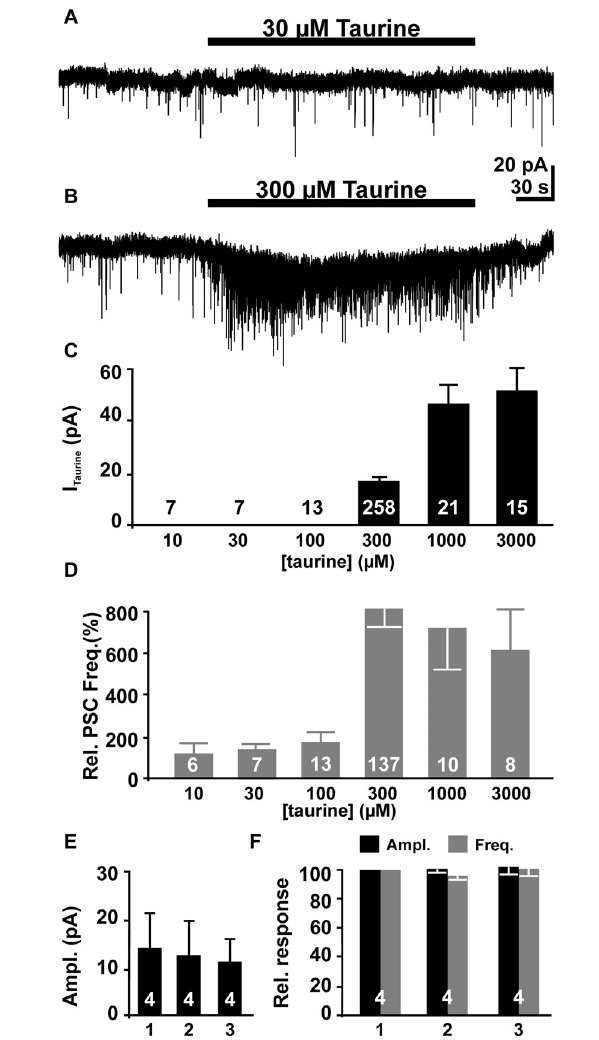
FIGURE 3 | The effect of bath-applied taurine on pyramidal neurons . (A) Whole-cell voltage-clamp recording from a pyramidal neuron. Bath application of 30 µ M taurine did not affect the holding current or the frequency of the PSCs. (B) Bath application of 300 µ M taurine induced an inward current and a massive increase in the frequency of PSCs. (C) Statistical analysis of inward current amplitudes induced by different taurine concentration. (D) Statistical analysis of relative PSC frequency (normalized to control intervals) in the presence of different taurine concentrations. Note that the effect of taurine on PSC frequency displays a clear threshold behavior. (E, F) Neither the amplitude of the inward current (E) , nor amplitude (black bars) and frequency (gray bars) of taurine-induced PSCs differ significantly in three consecutive applications. Bars represent mean ± SEM, number of experiments is given in the bars.